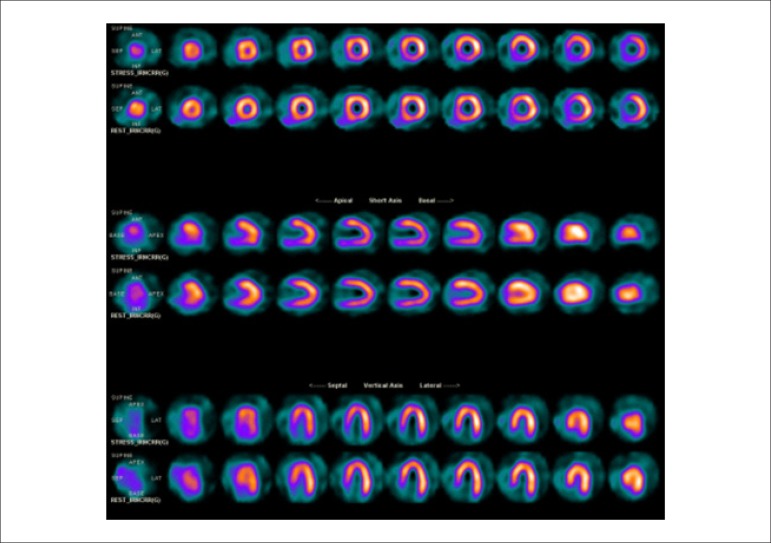
Case 9 - Myocardial perfusion scintigraphy demonstrating transient reduced uptake, characterized by mild intensity and small extent, suggestive of ischemia in the anteroseptal and septal walls and the apex. Images acquired with appropriate cardiac equipment (gamma camera), equipped with conventional sodium iodide crystals.